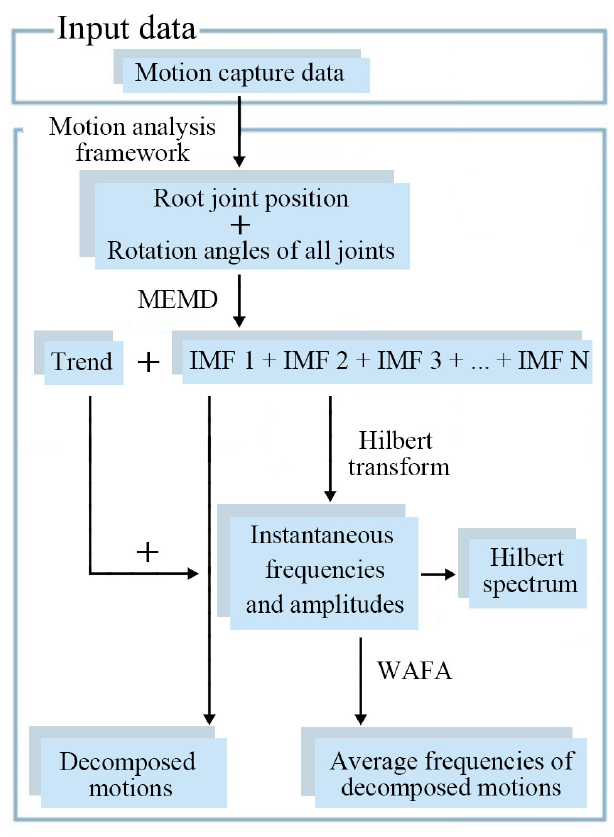
Figure 1. The proposed framework for motion analysis in the instantaneous frequency-domain using